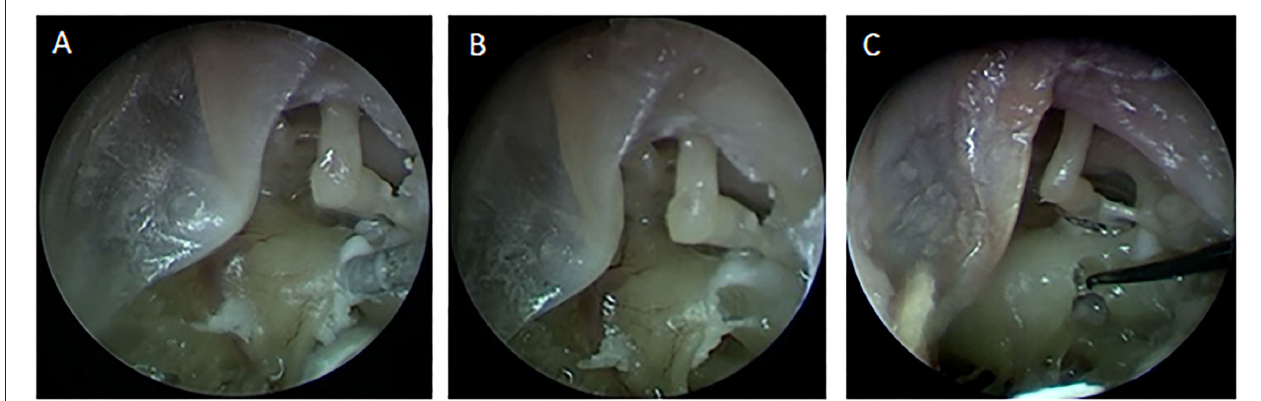
FIGURE 1 | (A) The milling of the inner ear access with visual endoscopic inspection through the tympanomeatal flap. (B) The 1mm inner ear access created for the electrode insertion. (C) Opening of the Round Window membrane using a micro-needle.